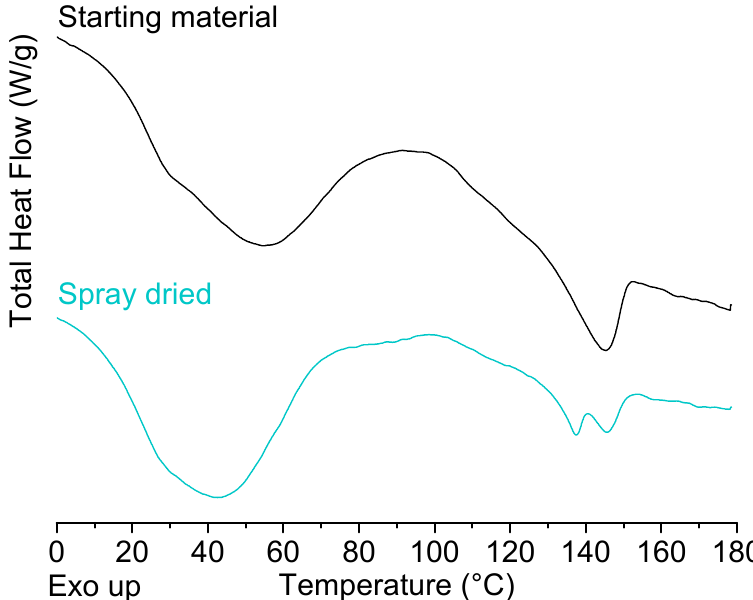
Figure 4. mDSC thermograms of the first heating cycle of PPrOx where the starting material (black) is compared to the spray dried material (cyan). Created with Origin 8.5 from OriginLab (Northampton, MA, USA).